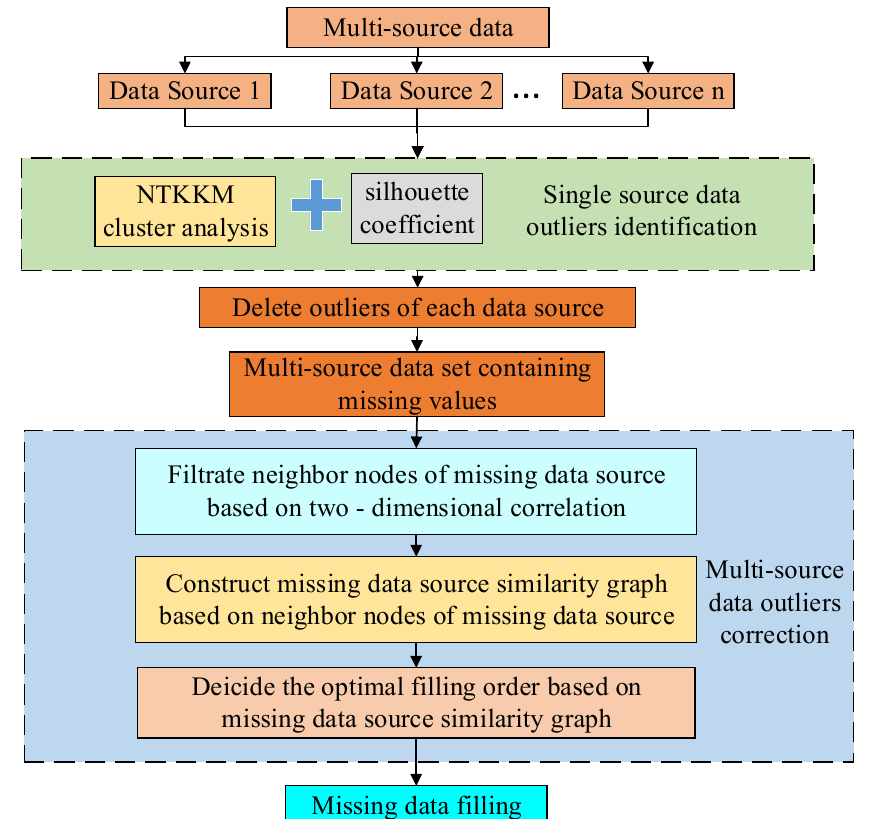
Figure 2. Intelligent identification and order-sensitive correction progress of outliers from multi-source data based on historical data mining.